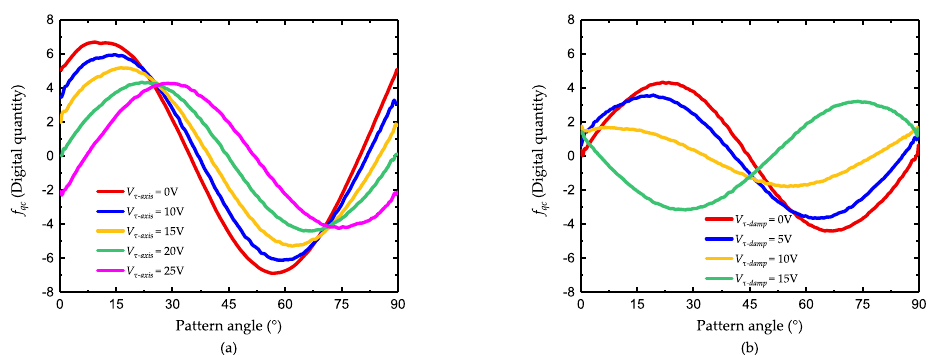
Figure 9. The value of f qc during damping tuning ( a ) during axis tuning and ( b ) during mismatch tuning.